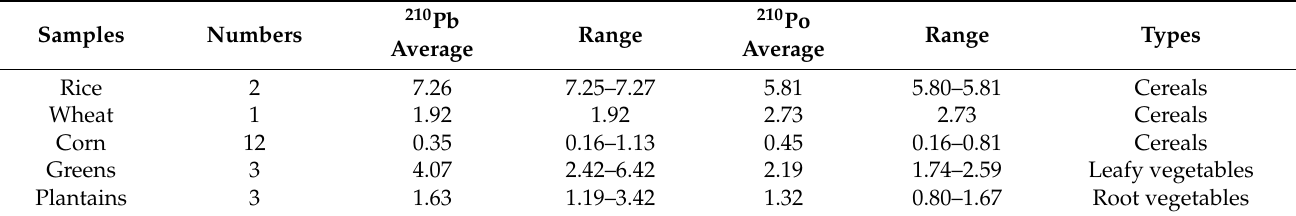
Table 5. Activity concentrations of 210 Pb and 210 Po in samples (Bq/kg · DW).